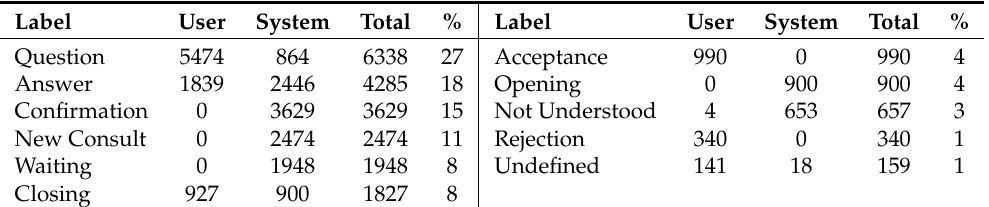
Table 3. Distribution of the domain-independent labels of Level 1 in the DIHANA corpus. The labels shown in this table are translations of the original labels in